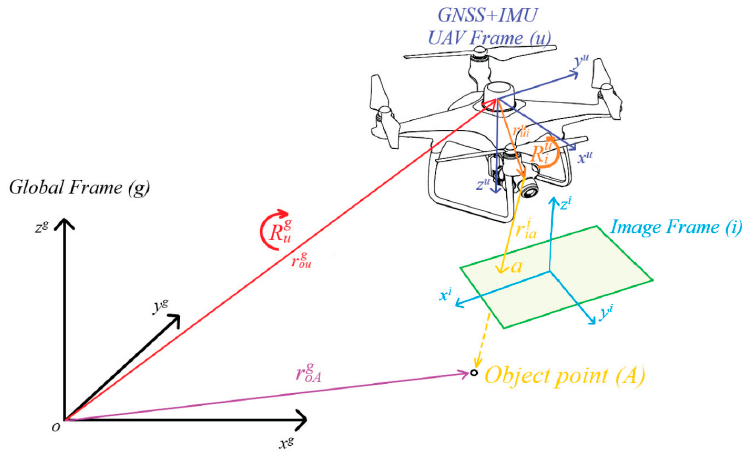
Figure 4. Observation geometry in mapping with unmanned aerial vehicle (UAV) photogrammetry [38].